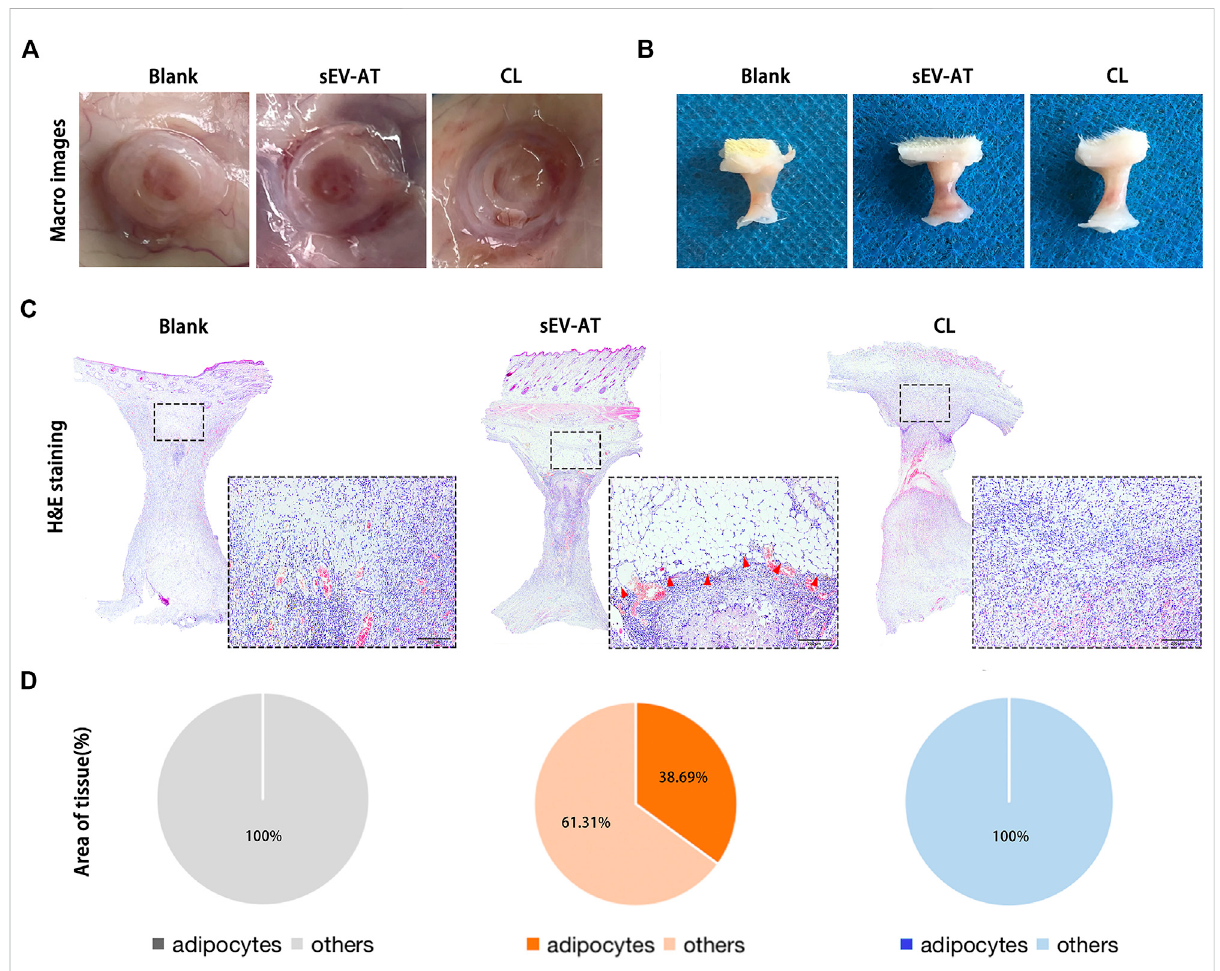
FIGURE 5 Adiposetissueregenerationintheimplants.Representativemacroimagesoftheimplants (A) withthetubesor (B) withoutthetubesat4 weeks. (C) Representative H&E-stained images of the implants at 4 weeks. (Black dotted square: areas were magni fi ed). The red triangles pointed out the regenerated adipose tissue. Scale bar = 200 µm. (D) The average percentage of adipose tissue area and other areas in the whole implants (n = 3).